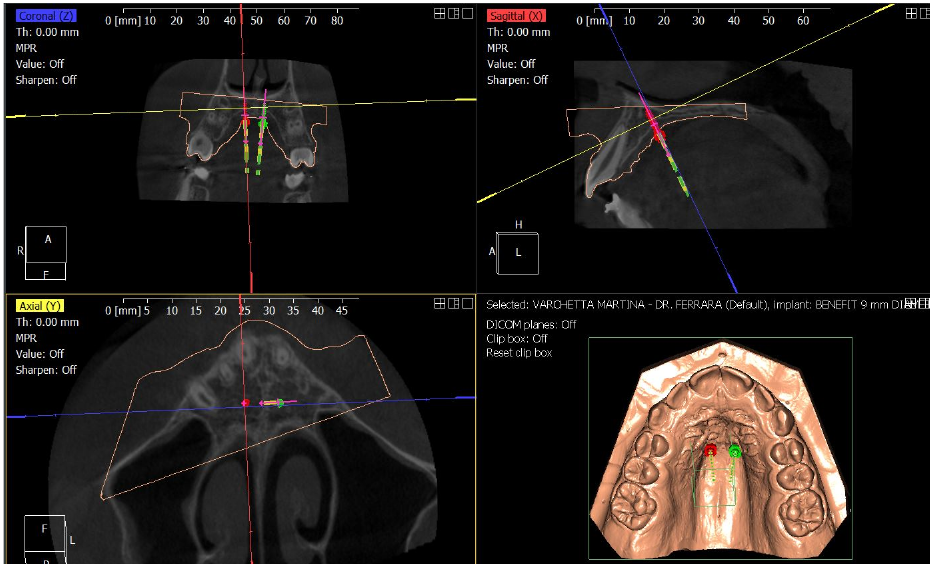
Figure 9. Digital planning with Easy Driver ® protocol.